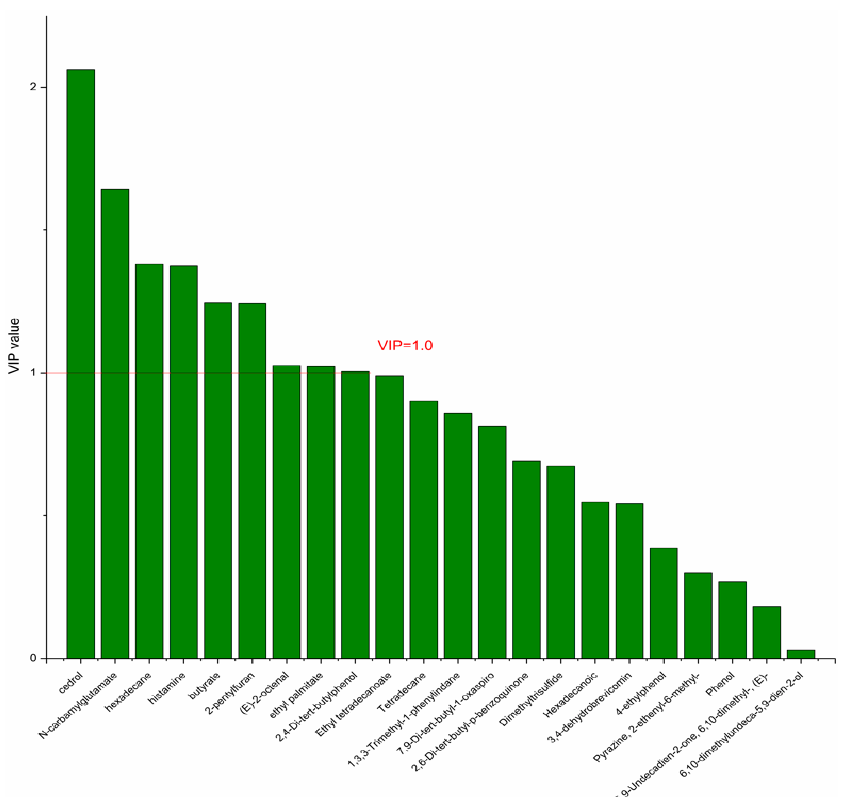
Figure 11. The VIP plot of the differential bacterial metabolites in DPA group vs. DHA group.